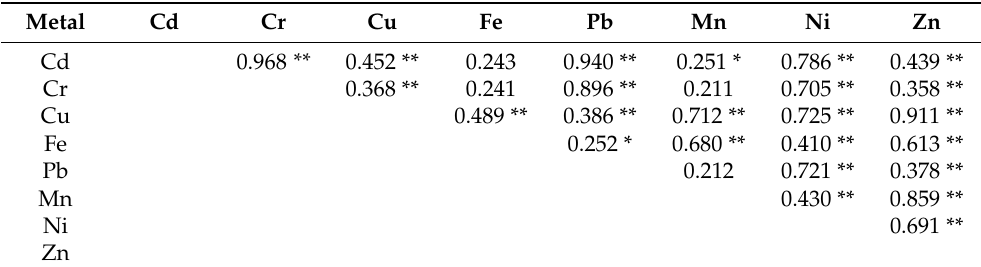
Table 10. Correlation analysis of heavy metals in surface water samples using International Business Machine(IBM) Statistical Package for Social Sciences (SPSS), N = 62.